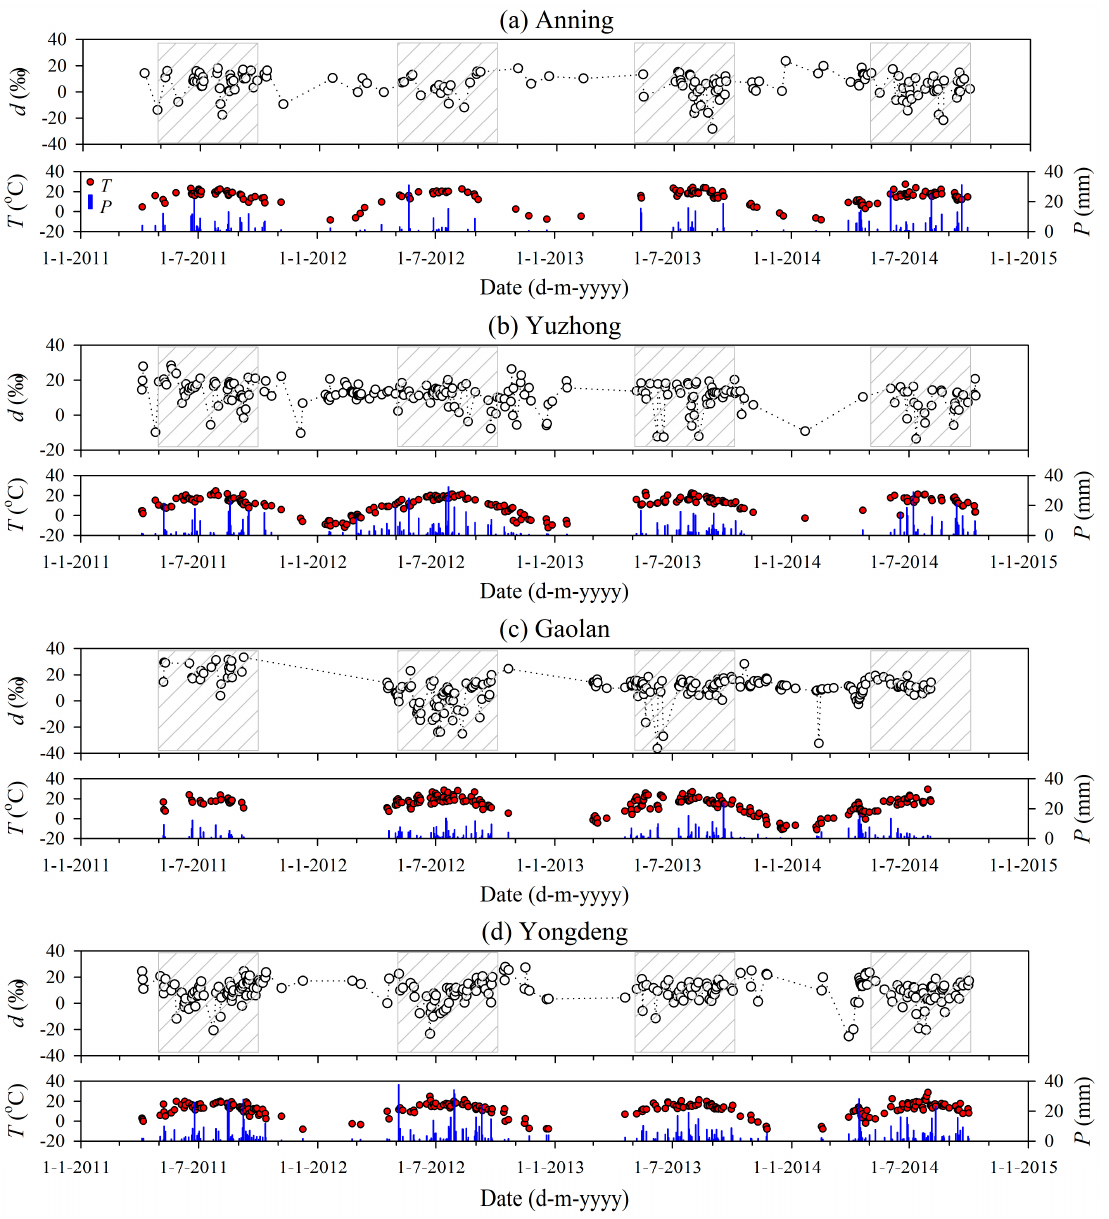
Figure 2. Variations of d value at the four stations in the Lanzhou city from 2011 to 2014.